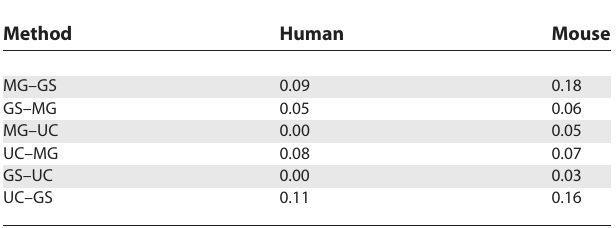
Table 8. Comparing the Results of MAGIC, GRIMM-Synteny, and the UCSC Genome Browser on Human–Mouse X